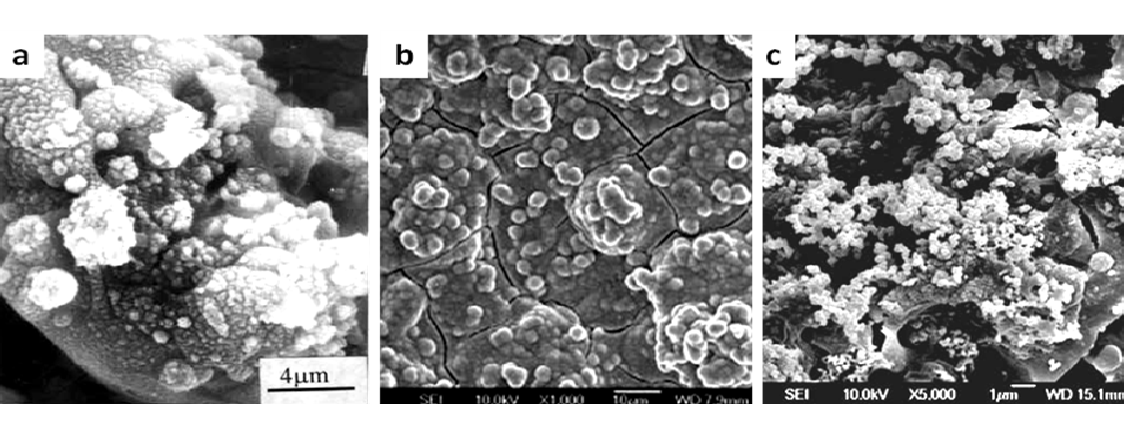
Figure 3. Comparison of bone-like apatite formation on plasma sprayed CaO-SiO bioceramic coatings after immersion in SBF solution: (a) CaSiO solution for 1 day. (b). Ca SiO coating immersed in SBF solution for 1 day. (c) 2 4 O coating immersed in SBF solution for 5 days. (Figure 3a and b are reprinted CaMgSi 2 6 with the permission from Liu, X.Y. [204,205]; Figure 3c is reprinted with the permission from Xue, W.C.